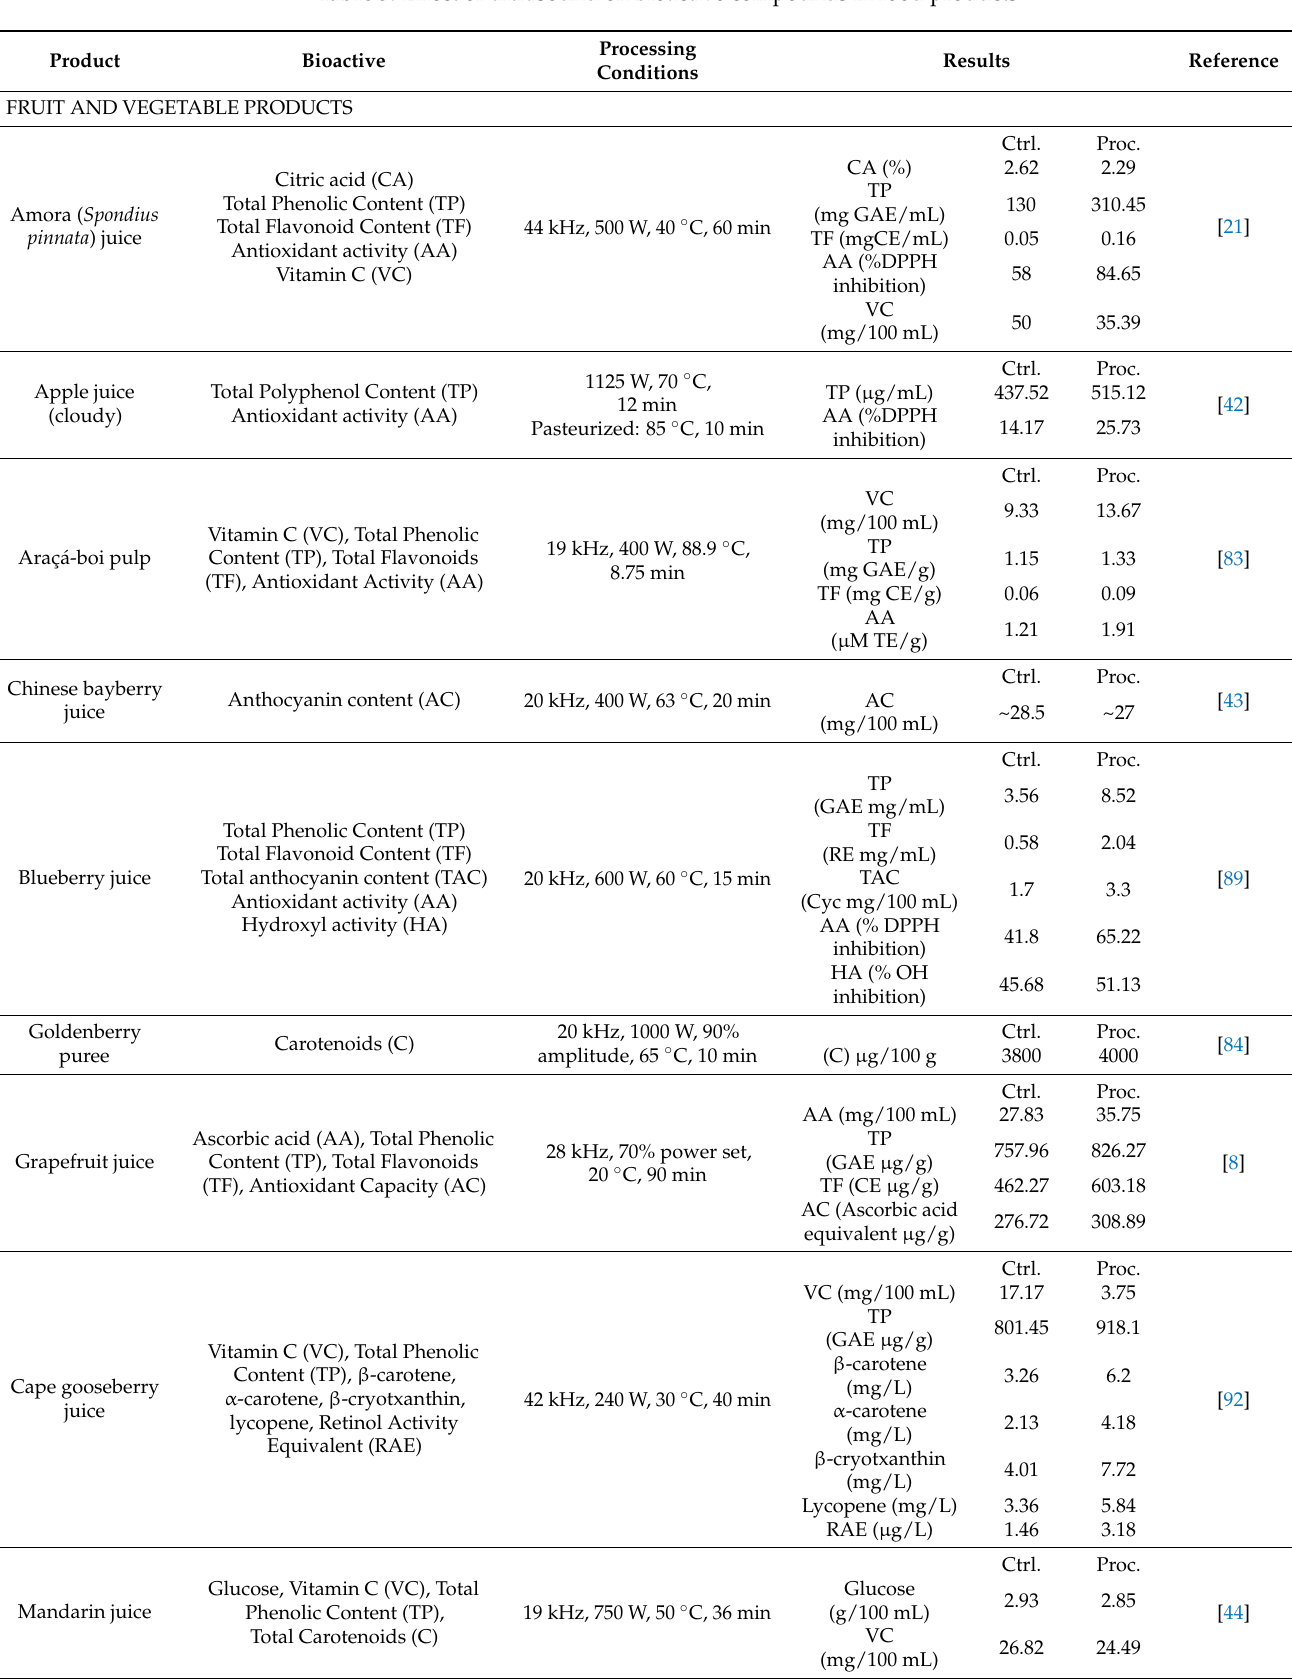
Table 3. Effect of ultrasound on bioactive compounds in food